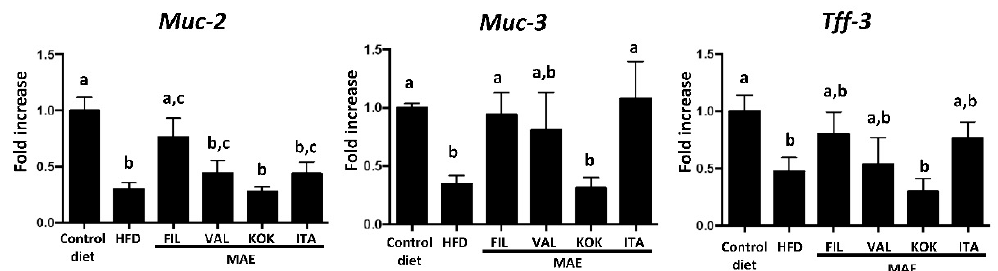
Figure 8. Effects after administration of Morus alba extracts ( genotypes Filipina , Valenciana temprana , Kokuso , and Italia ) in high fat diet (HFD)-fed mice on gene expression of intestinal barrier integrity markers, Muc-2 , Muc-3 , and Tff-3 , analyzed by real time qPCR. Data are expressed as means ± SEM ( n = 10). Groups with different letters statistically differ ( p < 0.05).